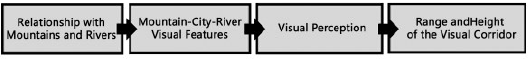
Figure 6. Illustration of decomposing the problem